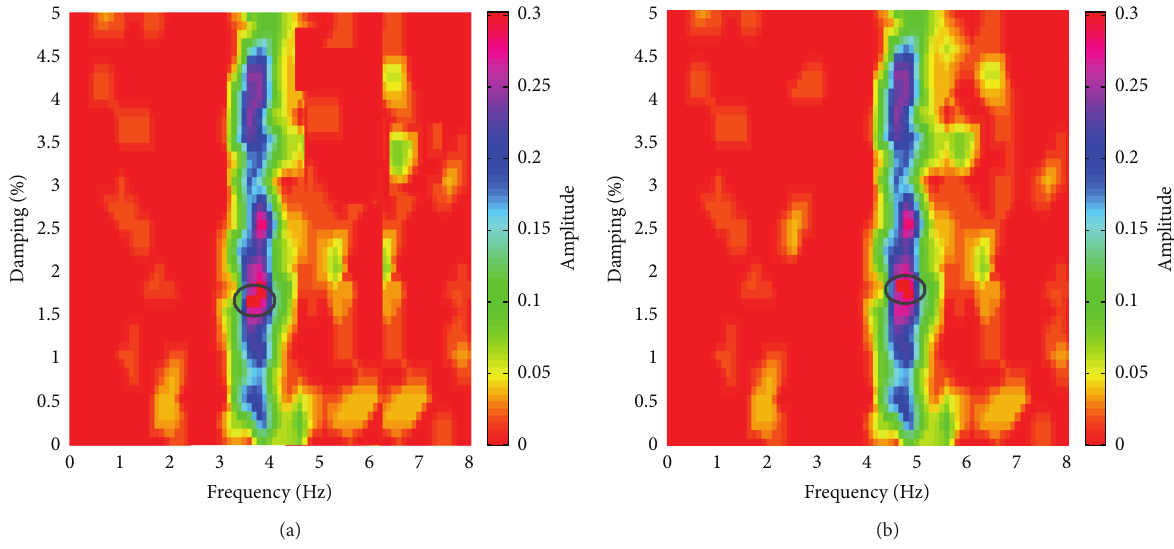
Figure 14: Example of NonPaDAn damping estimation performed for the first (a) and second (b) vibration modes of the dam. Maximum values, indicated by means of a black ellipse, correspond to each natural frequency and to the related modal